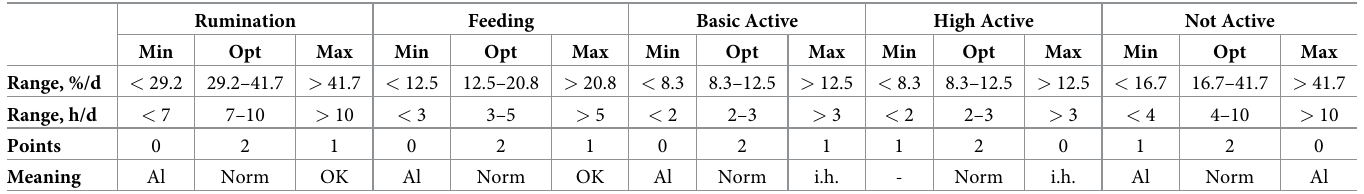
Table 5. Point assignment for welfare indices using the welfare quality assessment protocol 1